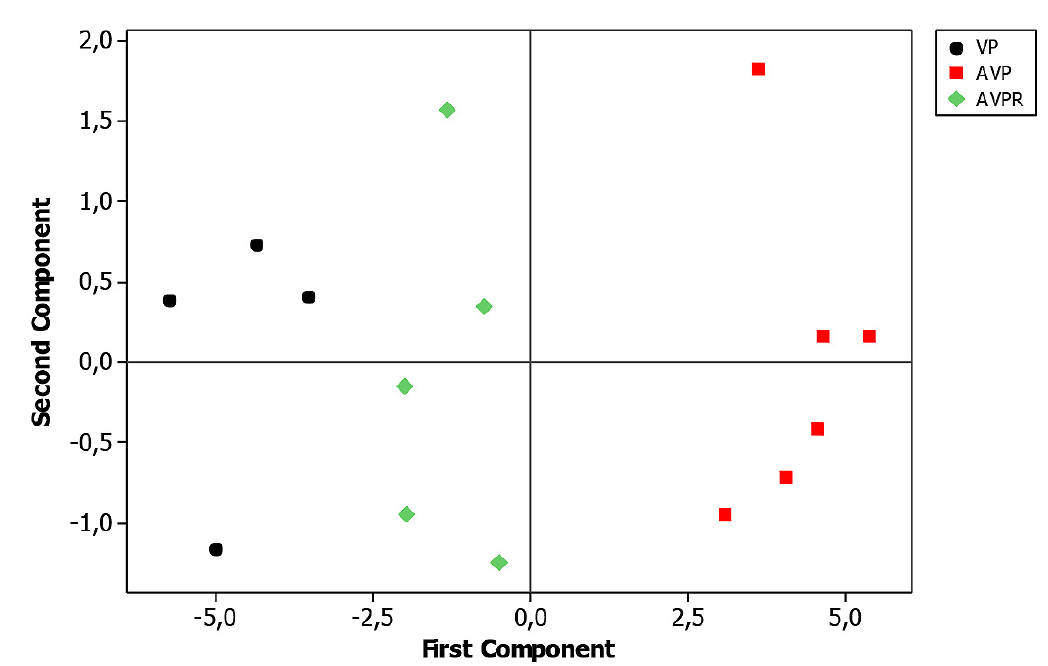
Figure 5. Principal component analysis of δ 13 C and δ 15 N values from experimental day 88 to 116.